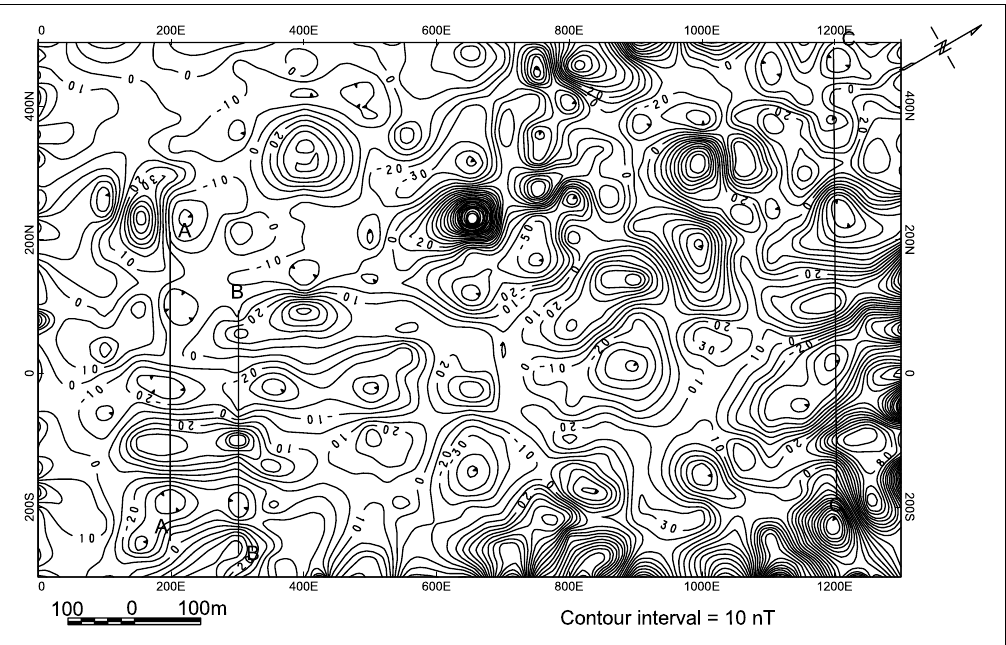
Fig. 6. High-pass filtered (frequency = 6-65 cycles/km) magnetic map of the Abu-Shihat radioactive prospect area, North Eastern Desert,